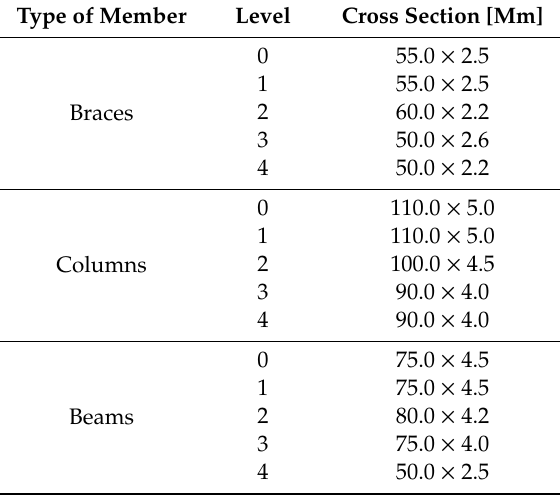
Table 1. Cross sections of the platform’s tubular members.